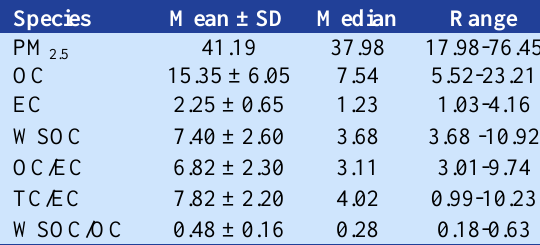
in different months during sampling